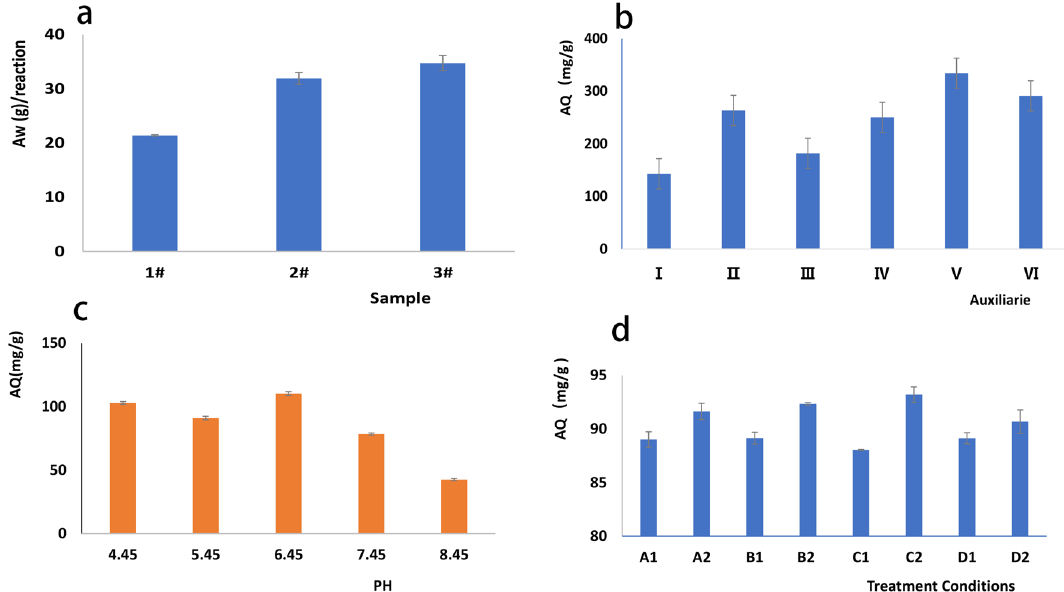
Figure 1. ( a ) Yields of NZV-FeZn (1#), rGO/NZV-FeZn (2#), and GAC sp/ NZV-FeZn (3#) per unit mass. ( b ) Effects of auxiliaries on the efficiency of Sb(V) removal by rGO/NZV-FeZn. ( c ) Effect of pH on the efficiency of Sb(V) removal by rGO/NZV-FeZn. ( d ) Effects of illumination and oxygen on the efficiency of Sb(V) removal by